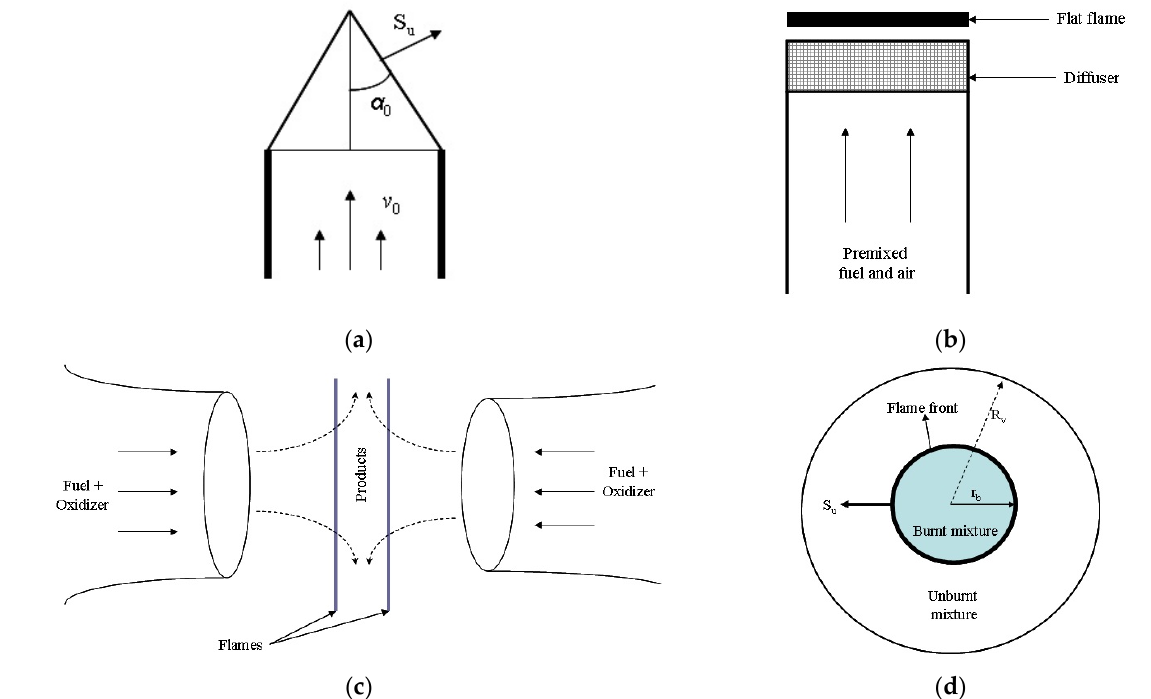
Figure 2. Schematic representation of different experimental methods: ( a ) Bunsen burner; ( b ) Flat flame burner; ( c ) Counter-flow twin flames; ( d ) Closed vessel method.